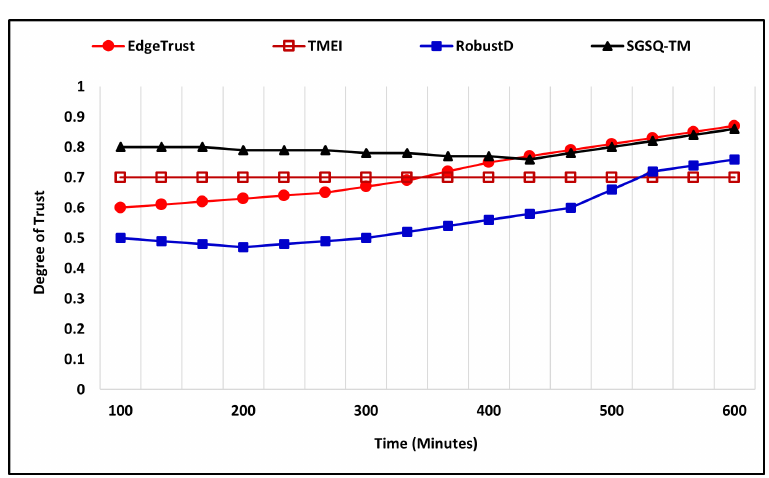
Figure 13. Bad mouthing attacks in